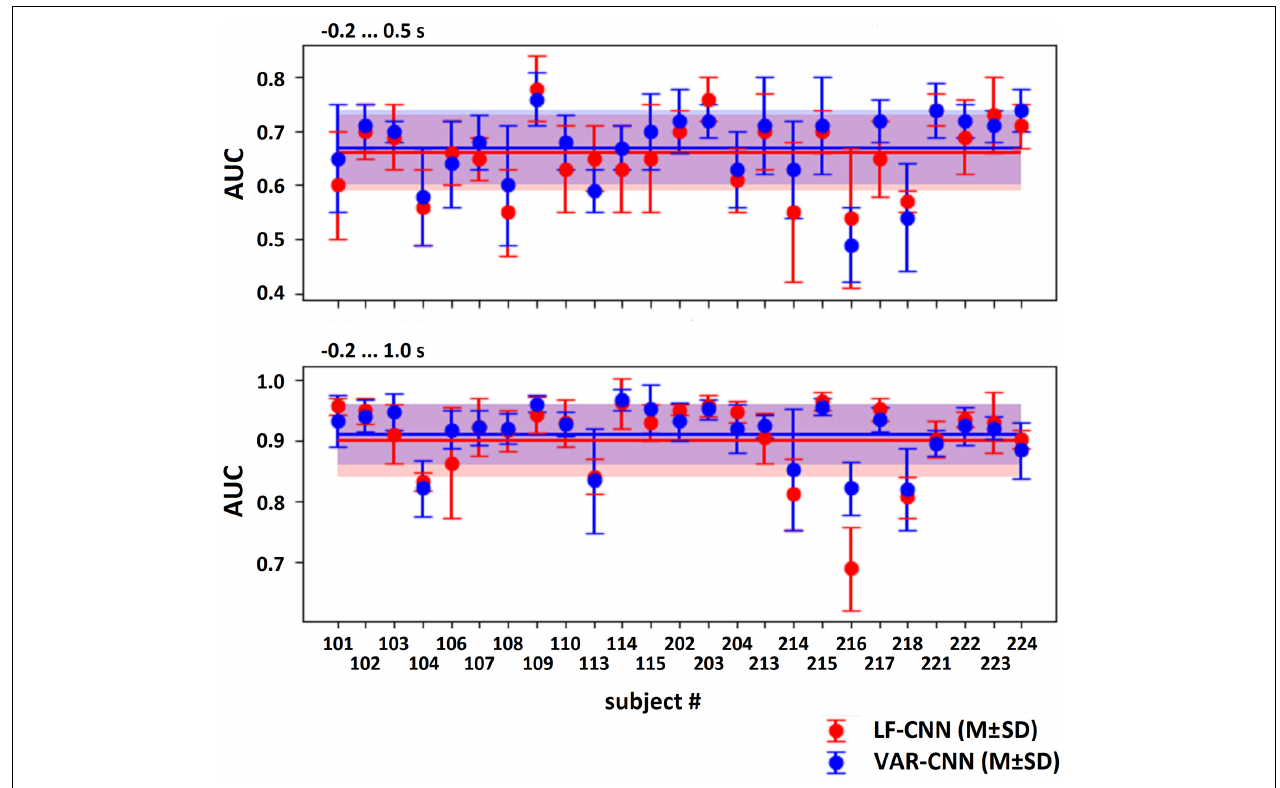
FIGURE 4 | AUC values ( M ± SD) for both CNNs, computed by naïve testing method for the test subsets of every participant.